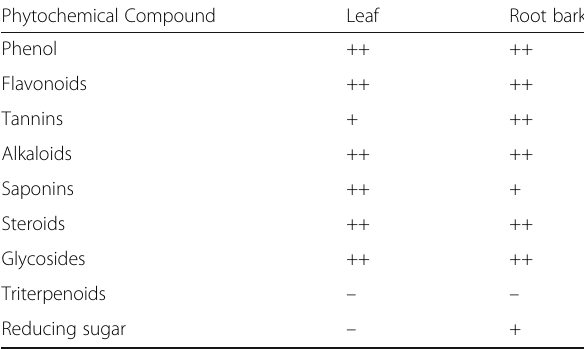
Table 5 Qualitative Phytochemical Screening of Petiveria alliacea leaf and root bark Phytochemical Compound Leaf Root bark Phenol ++ ++ Flavonoids